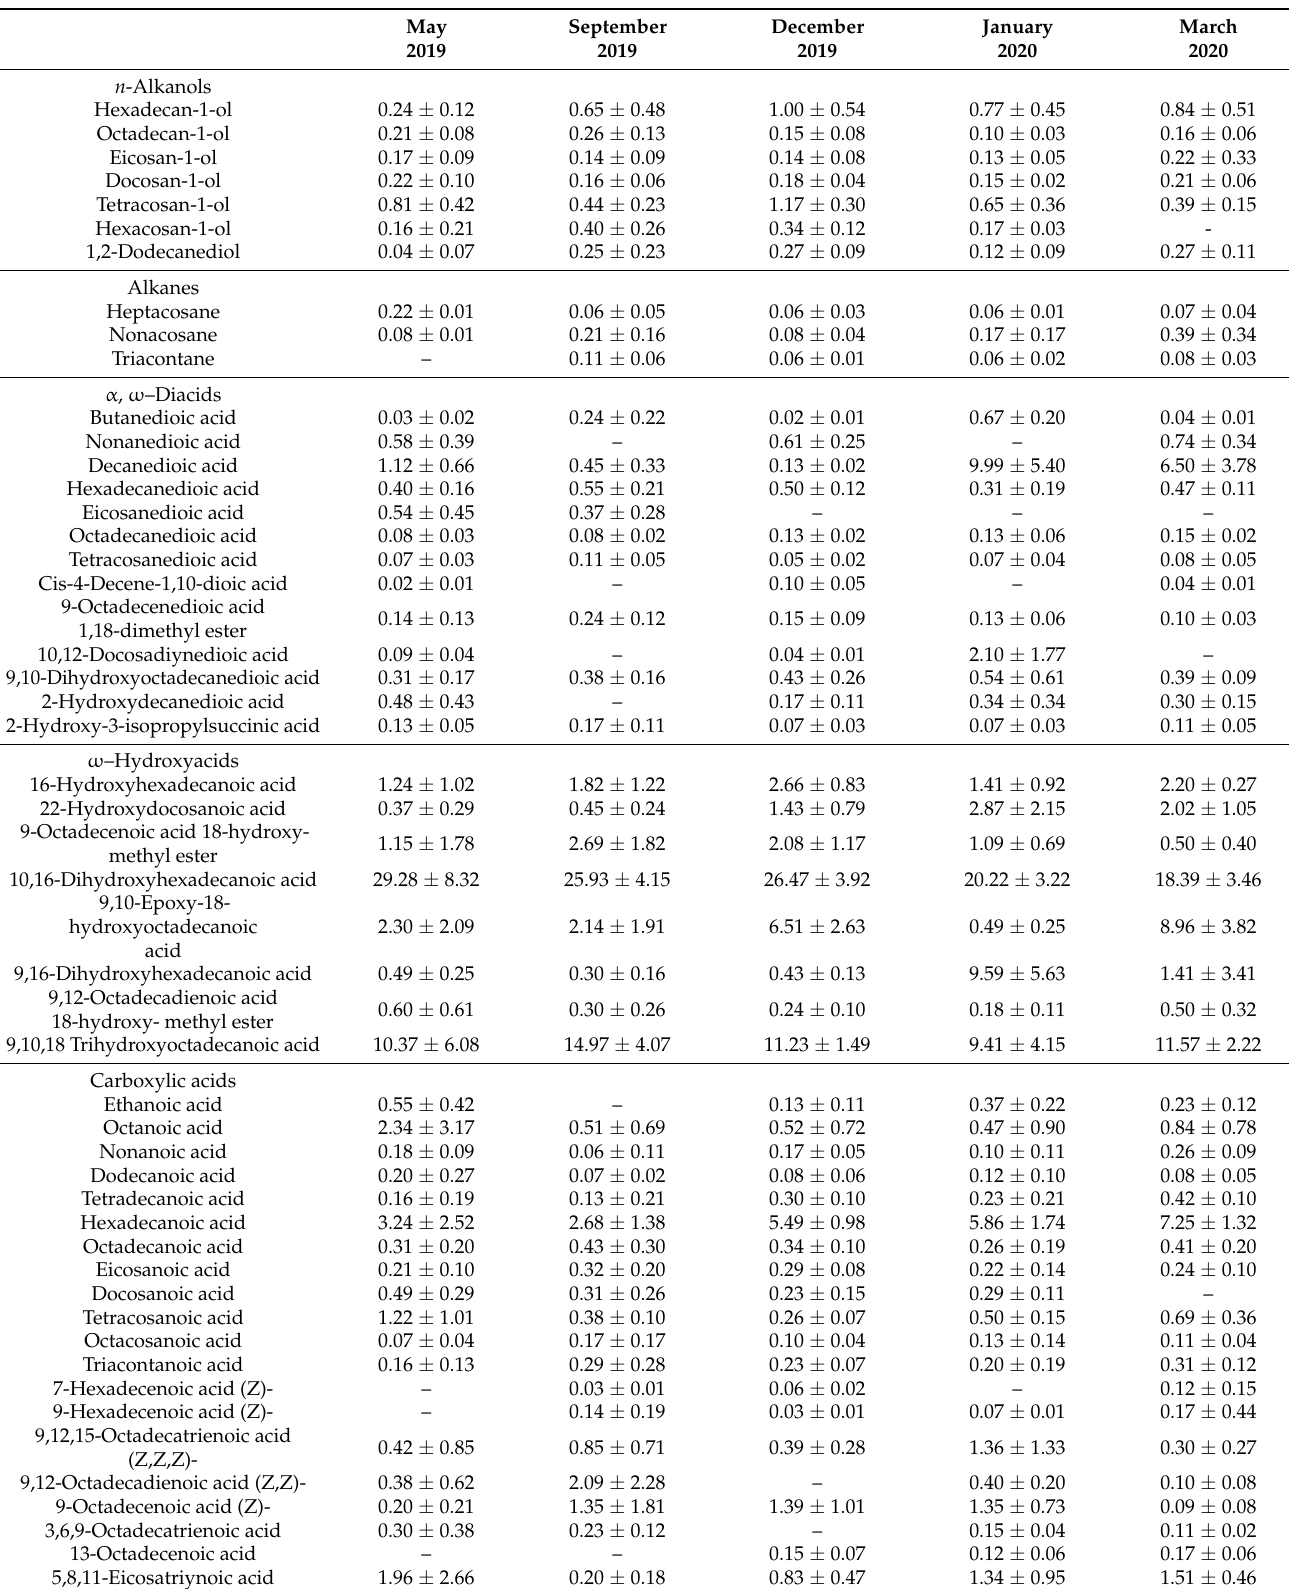
Table 2. Seasonal variation in cutin composition in cork oak ( Quercus suber ) leaves (mean of six provenances with two trees per provenance), as determined by GC–MS, as a % of total peak area (only compounds with a proportion over 0.10% are